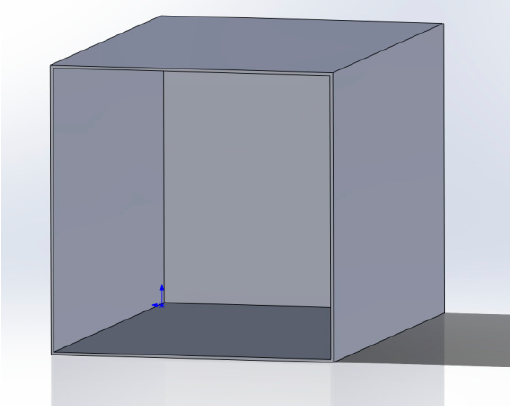
Figure 49. Cold Case Altitude Control Block Diagram.